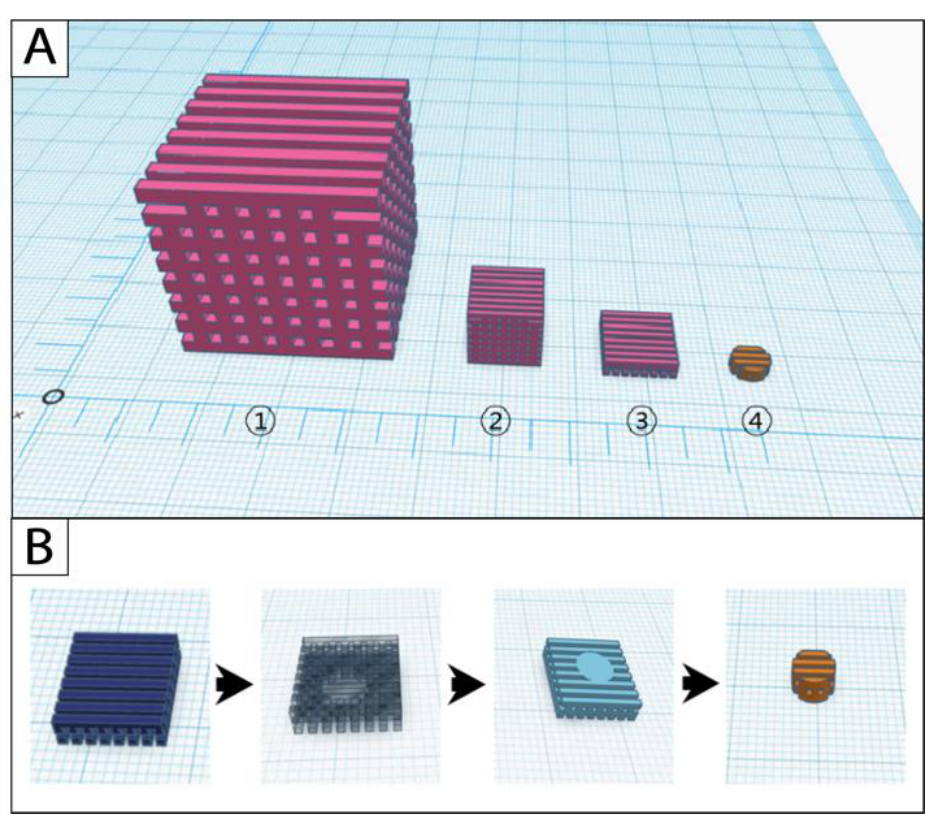
Figure 2. Simulations of the ( A ) scaffold modification and ( B ) postprocessing steps in the software Tinkercad. 1: original scaffold, 2: scaling scaffold, 3: model scaffold, 4: cell culture scaffold.